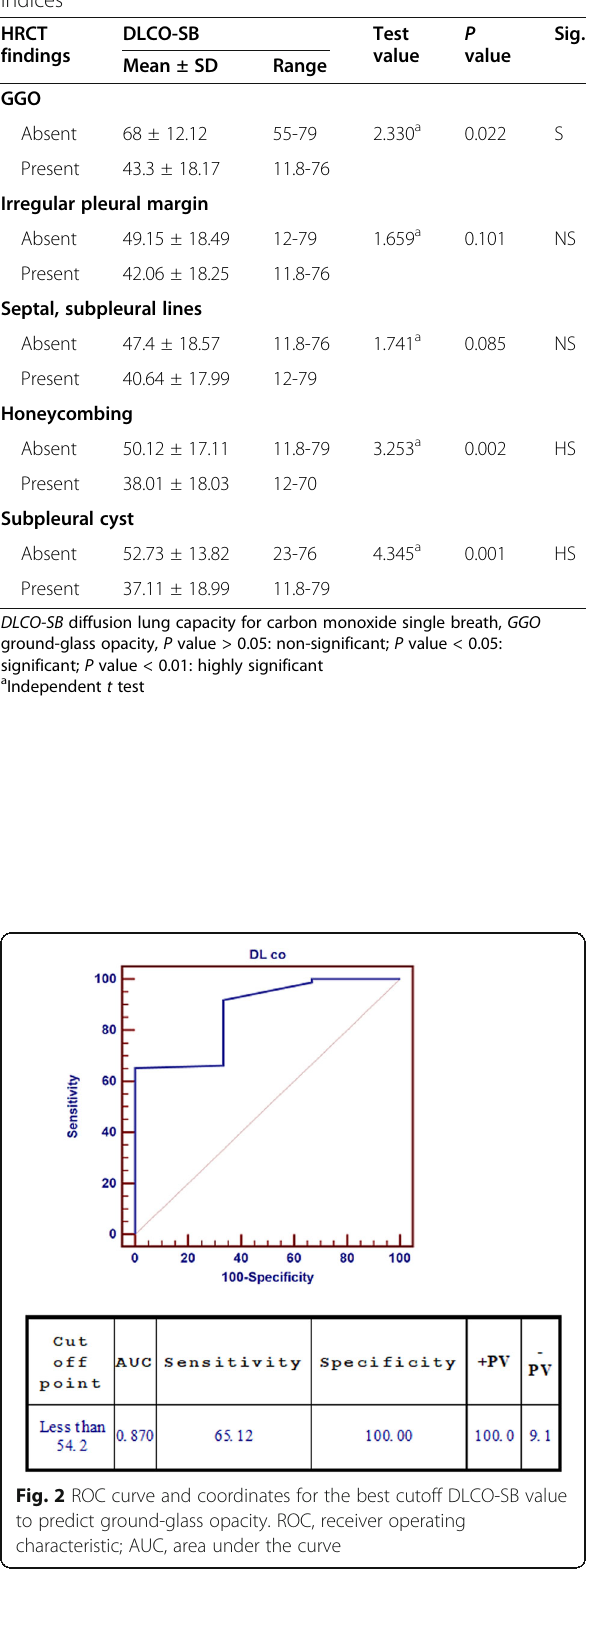
Table 9 Correlation between DLCO-SB and Warrick ’ s score